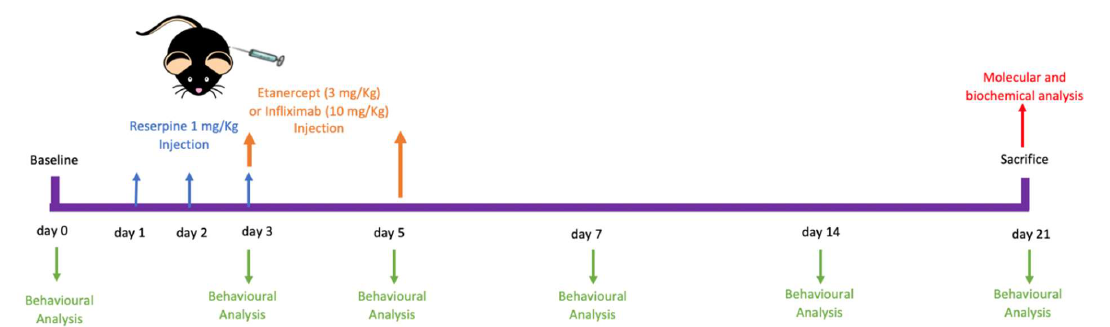
Figure 1. Schematic of study design.